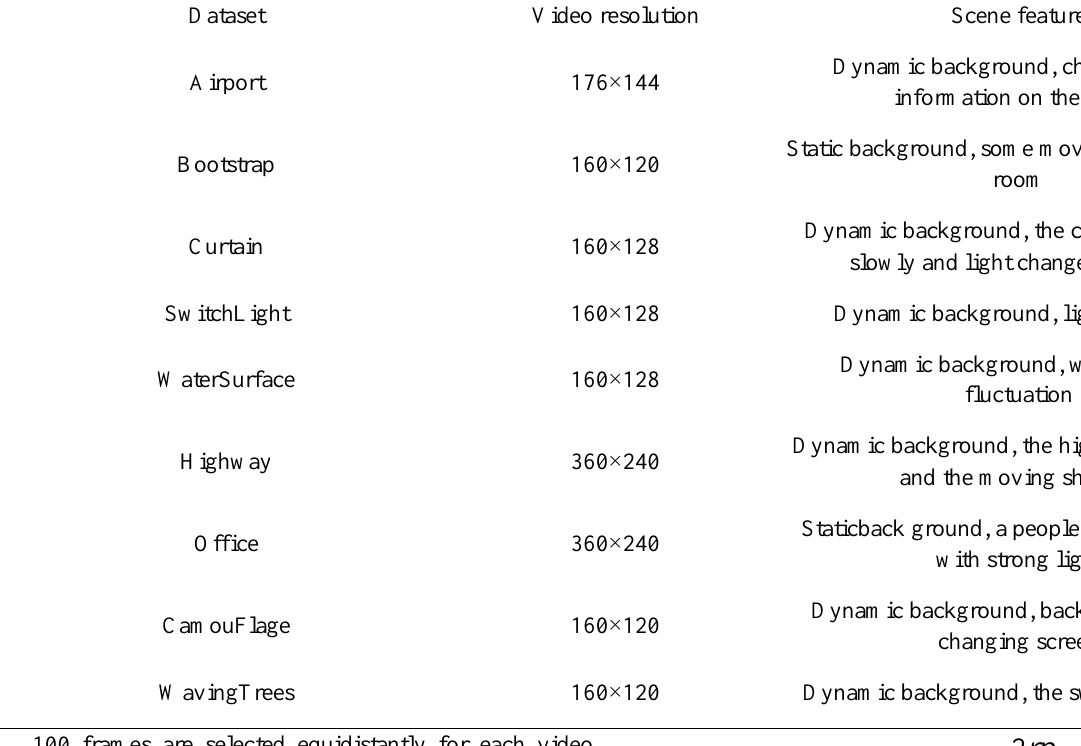
Table 1. Information of 9 video datasets for